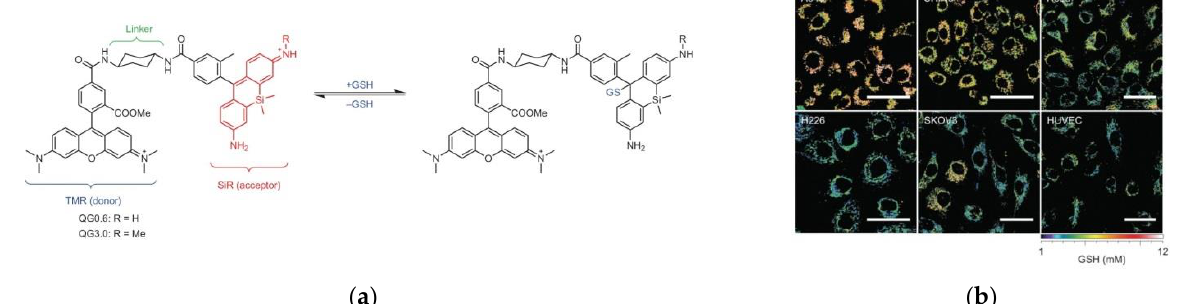
Figure 19. ( a ) Mechanism of QuicGSH activation by GSH; ( b ) Quantification of GSH in several cell lines. Reproduced with permission from [86]. Copyright 2016 Nature.